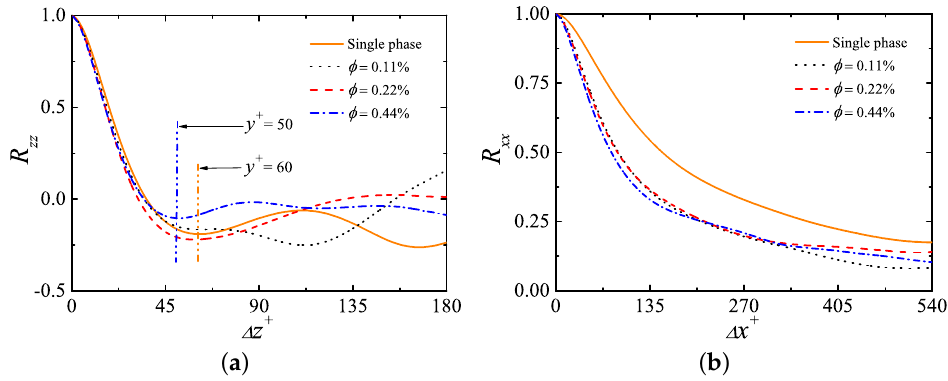
Figure 8. Autocorrelation coefficients of the streamwise velocity fluctuations versus the separations at y + = 13.8 plane: ( a ) In the spanwise direction and ( b ) in the streamwise direction.